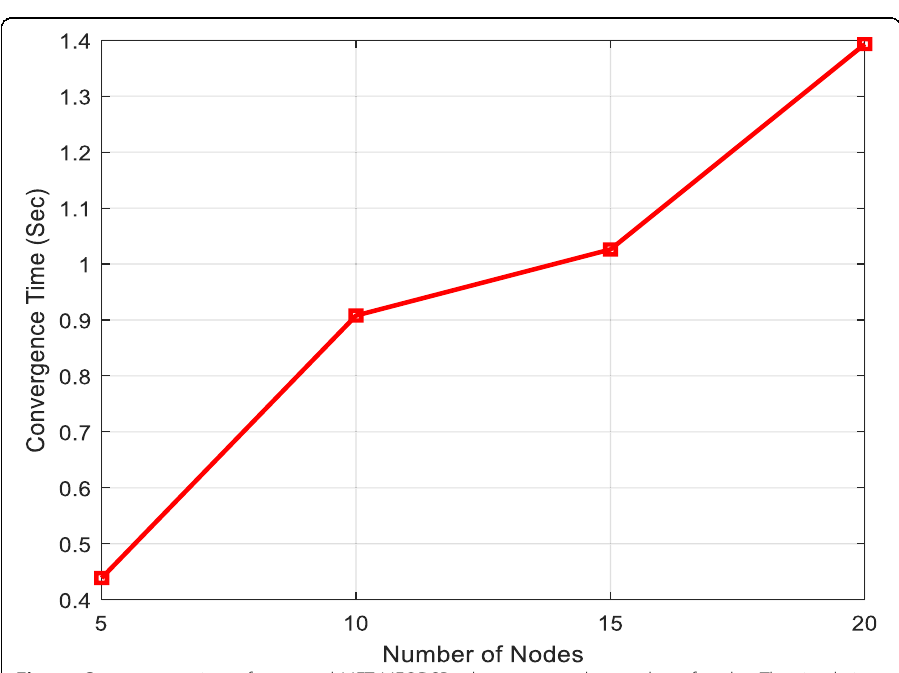
Fig. 15 Convergence time of proposed MET-MFODSR scheme versus the number of nodes. The simulation results of the convergence time of the MET-MFODSR using the CRAWDAD dataset concerning the number of